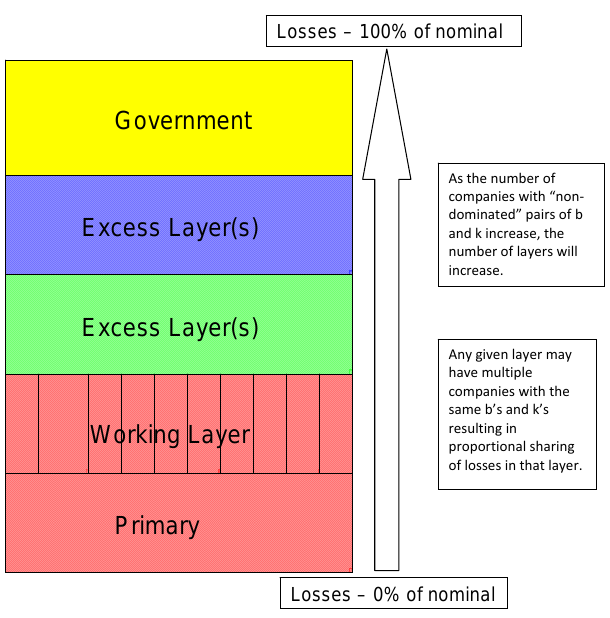
Fig. 10. Insurance programme prospective of risk